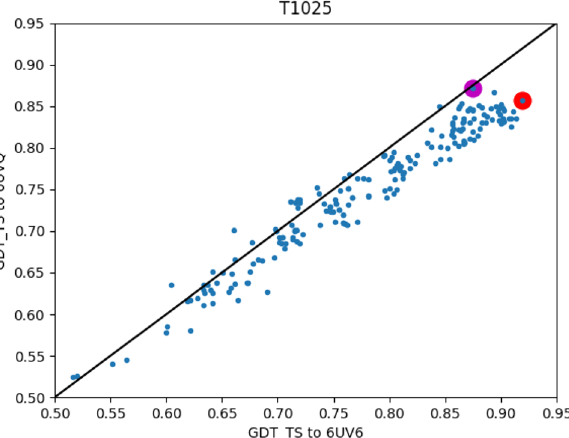
Figure 10. Model accuracy with respect to two alternative native structures. Target T1025 was evaluated by the CASP14 assessors with the ligand-bound D-glucose O -methyltransferase as its native structure (PDB entry 6UV6 69 ). The structure of the unbound protein is also available (PDB entry 6UVQ 70 ). While the choice of either structure is arbitrary, the resulted performance measures are quantitatively different. A theoretical EMA oracle that provides 6UVQ based accuracy as its prediction, would have 4% RMSE and 6% LOSS. The dots represent server models, the black line is the diagonal (x = y), and the red and magenta circles depict the top model by 6UV6 and 6UVQ